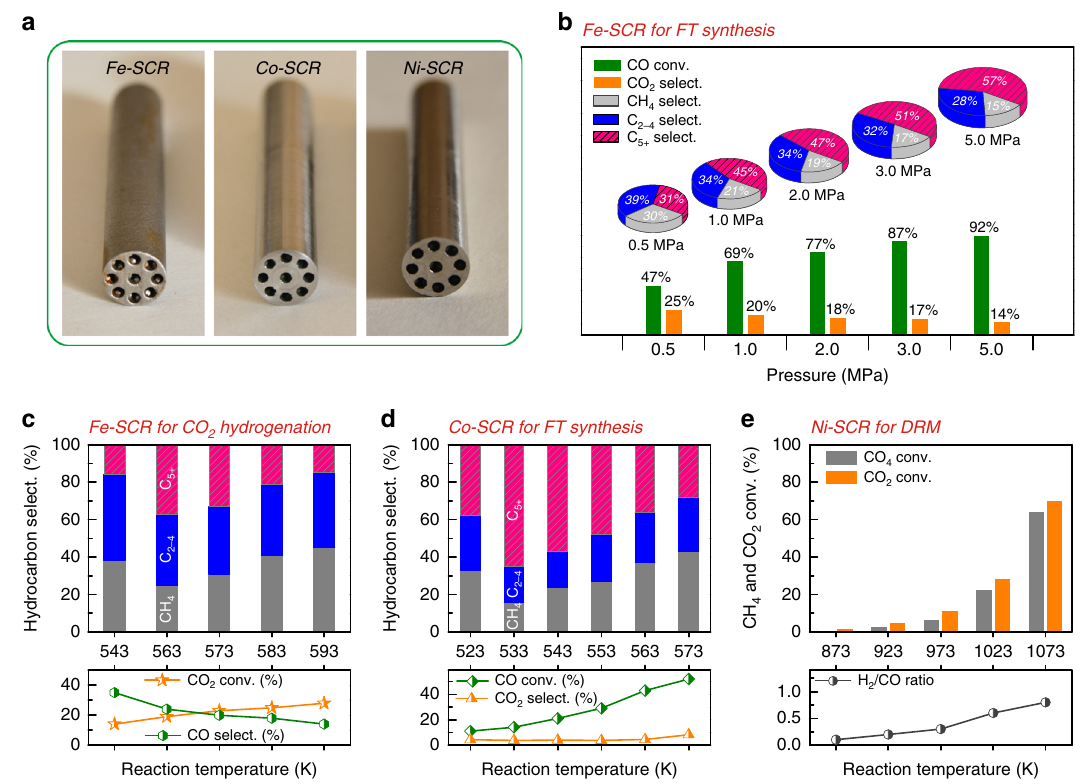
Fig. 2 Catalytic performance of SCRs. a The physical SCRs after polishing the outer surface. b Fe-SCR for Fischer – Tropsch synthesis. Reaction conditions: T = 573K; H 2 /CO = 2.0; fl ow rate, 20mlmin − 1 ; time on stream, 10h. c Fe-SCR for CO 2 hydrogenation. Reaction conditions: P = 1.0MPa; H 2 /CO 2 = 3.0; fl ow rate, 20mlmin − 1 ; time on stream, 10h. d Co-SCR for Fischer – Tropsch synthesis. Reaction conditions: P = 2.0MPa; H 2 /CO = 2.0; fl ow rate, 20mlmin − 1 ; time on stream, 10h. e , Ni-SCR for CO 2 reforming of CH 4 . Reaction conditions: P = 0.1MPa; CO 2 /CH 4 /Ar = 45/45/10; fl ow rate, 40mlmin − 1 ; time on stream,